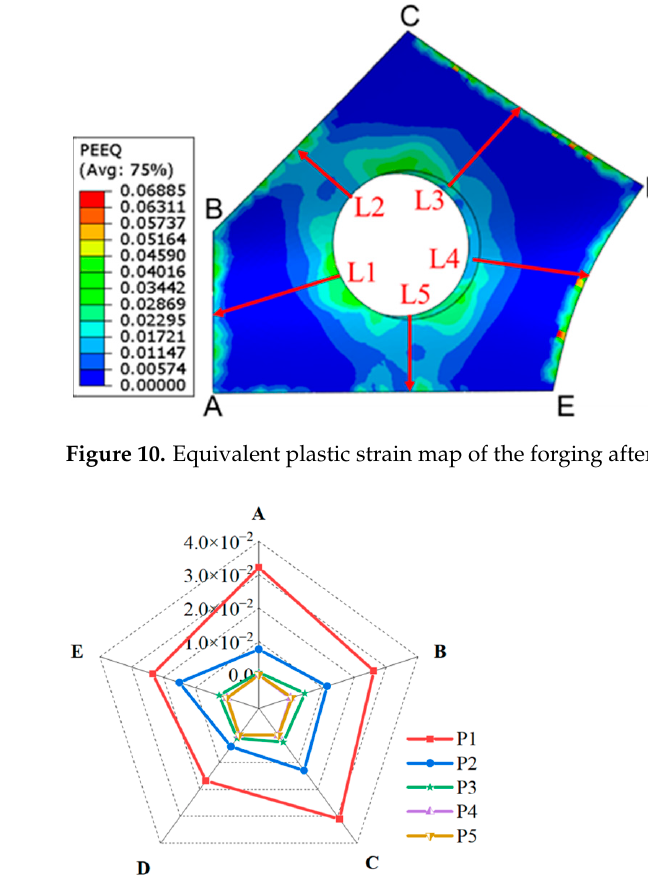
Figure 11. Equivalent plastic strain of the forging.